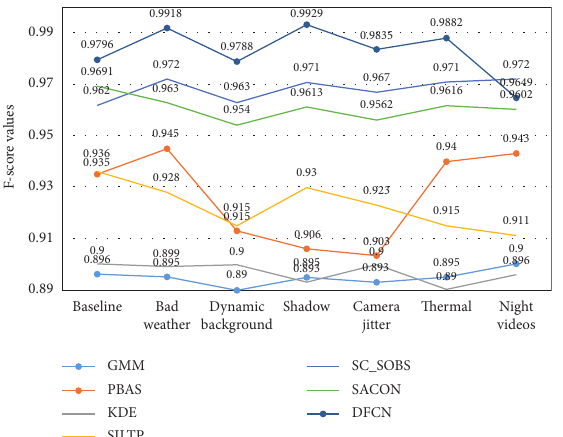
Figure 9: F-score value comparison of input data using different colour